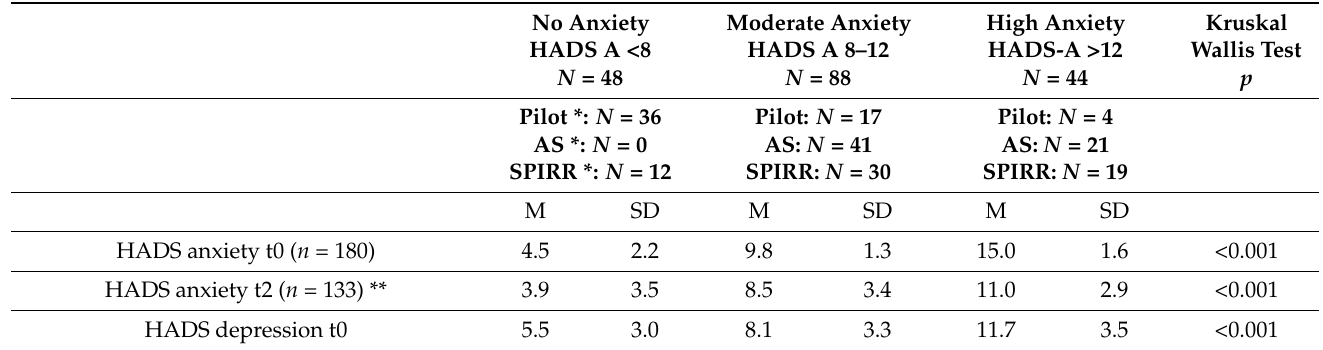
Table 2. Anxiety Characteristics in 180 CHD patients of the BAT